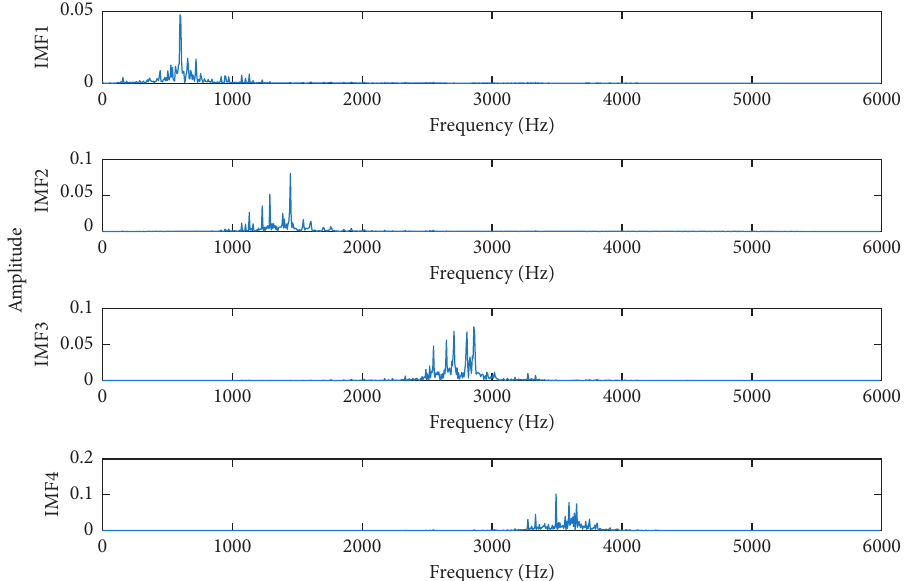
Figure 7: The frequency-domain diagram after inner ring fault signal decomposition.